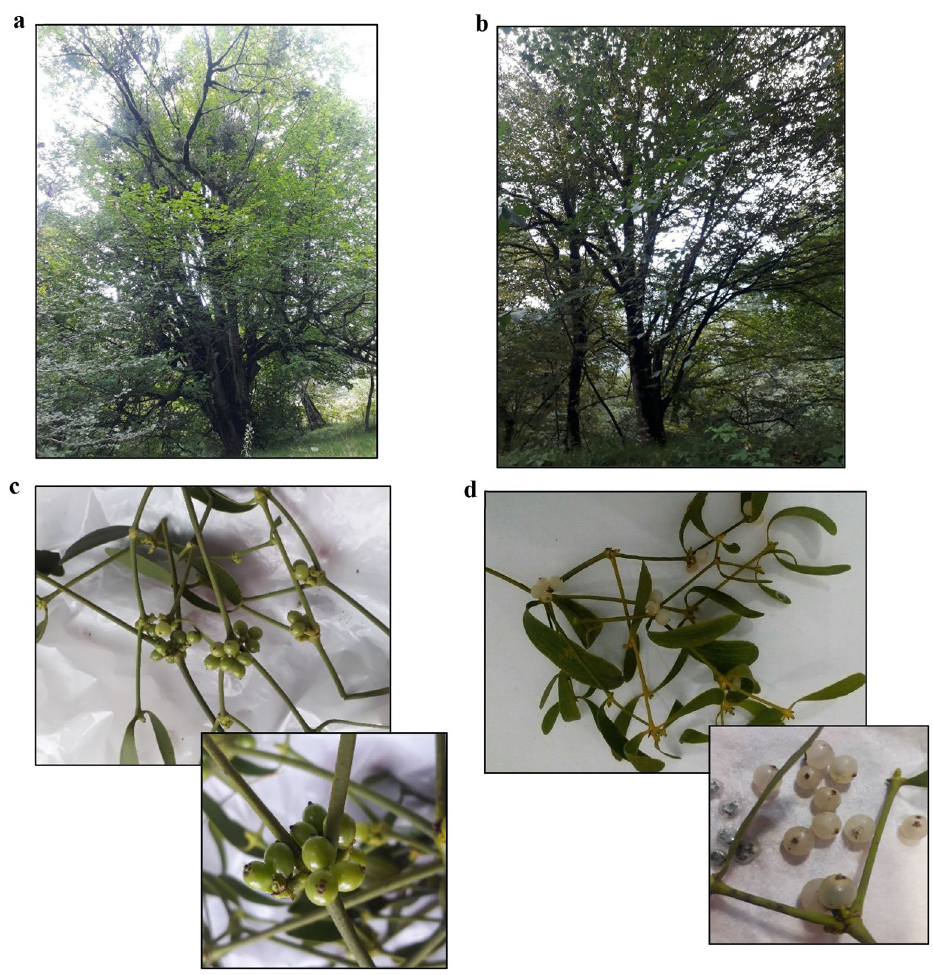
Figure 3. Sampling of mistletoe plants from 2 different host trees. ( a ) P. persica , ( b ) C. betulus , ( c ) mistletoe in green berry phenological stage and ( d ) mistletoe in white berry phenological